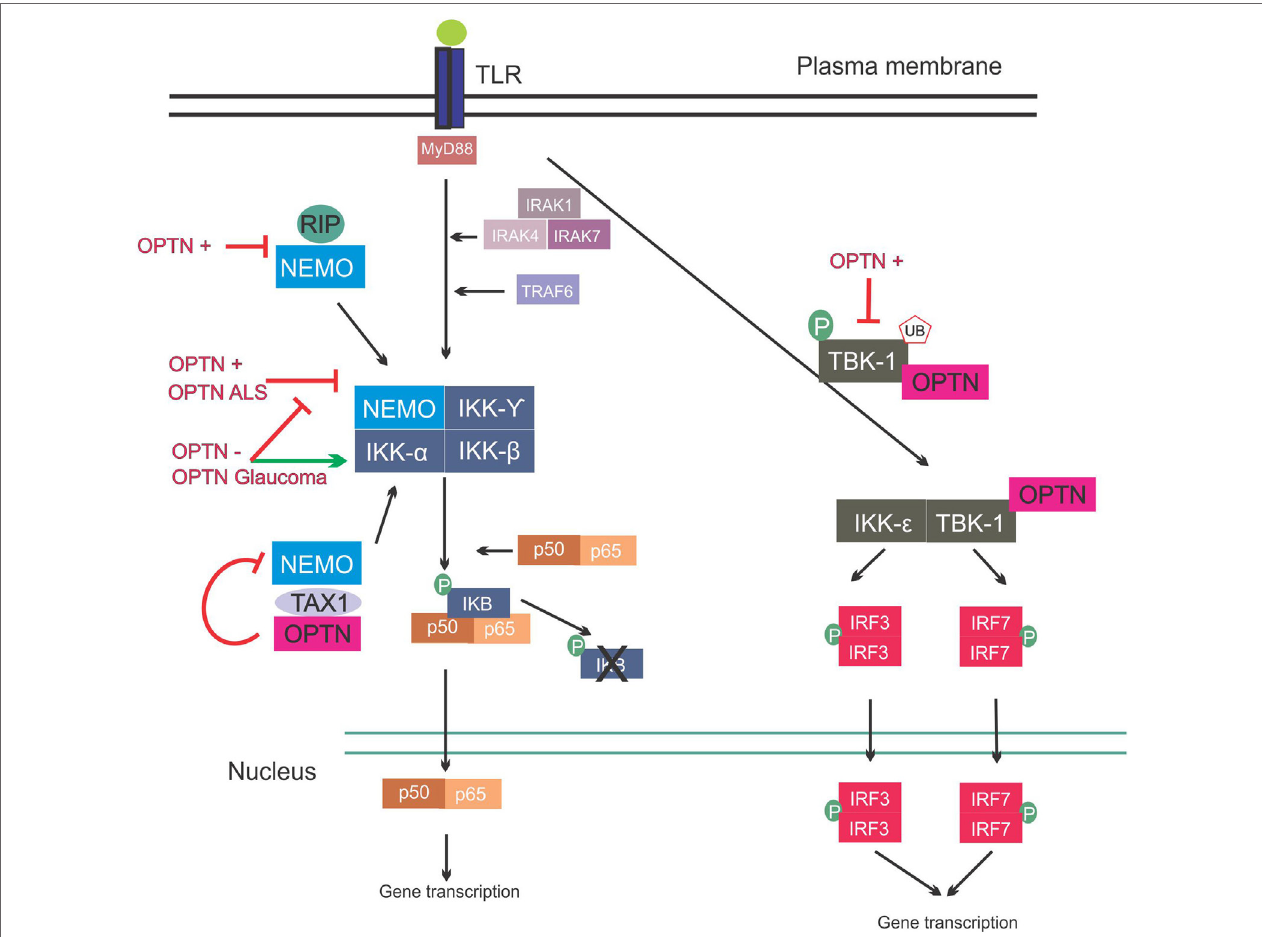
FiGURe 3 | Involvement of optineurin in nuclear factor kappa B (NF- κ B) signaling. Upon Toll-like receptor (TLR) signaling the NF- κ B pathway is activated, leading to expression of inflammatory cytokines. This is mediated via interleukin-1 receptor-associated kinases (IRAKs) and TRAF. NEMO binds to the I kappa B (IKB) complex, leading to its phosphorylation and consequent degradation, and translocation of p50/p65 to the nucleus. NEMO also interacts with receptor-interacting protein (RIP) and trans-activating transcriptional regulatory protein of HTLV-1 (TAX1). Overexpression of wild-type or ALS mutant optineurin blocks NF- κ B activation. Depletion of optineurin or overexpression of the glaucoma mutants leads to failure to inhibit NF- κ B, leading to activation of this pathway. Optineurin binds to TAX1, blocking its interaction with NEMO and further inhibiting the pathway. Interferon regulatory factors are activated during TLR activation. IRF3 and IRF7 activation is mediated by TBK-1, and TBK-1 undergoes phosphorylation and ubiquitination during its activation. Optineurin binds to TBK-1, targeting it to CYLD, which inhibits its enzymatic activity. Abbreviations: OPTN − : optineurin depletion, OPTN + : optineurin overexpression, OPTN ALS: ALS mutant optineurin, OPTN Glaucoma: glaucoma mutant